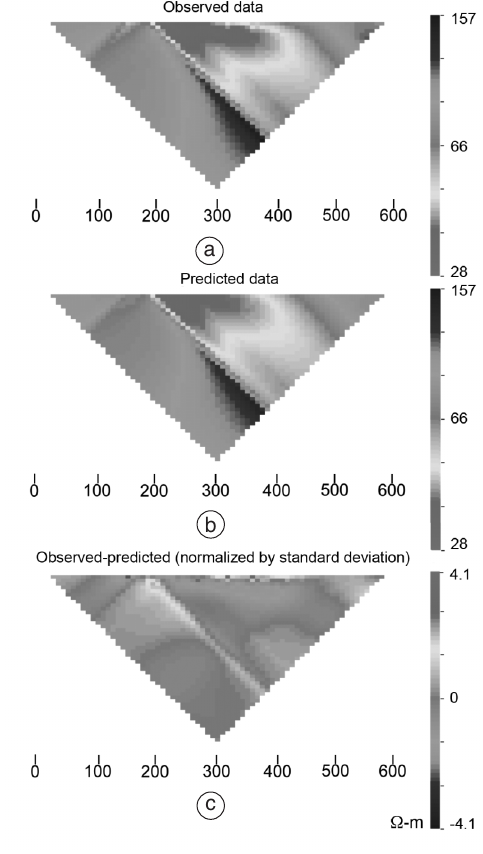
Fig. 14a-c. Result of geophysical inversion, pdL con- figuration, Model 3, at 300 days: a) observed data; b) predicted data; c) difference between observed and predicted